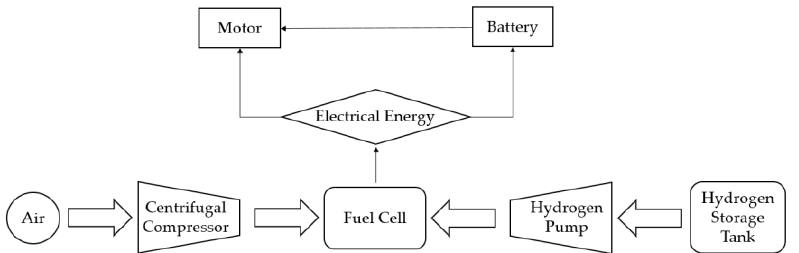
Figure 1. Schematic diagram of a typical hydrogen fuel cell system for vehicles.